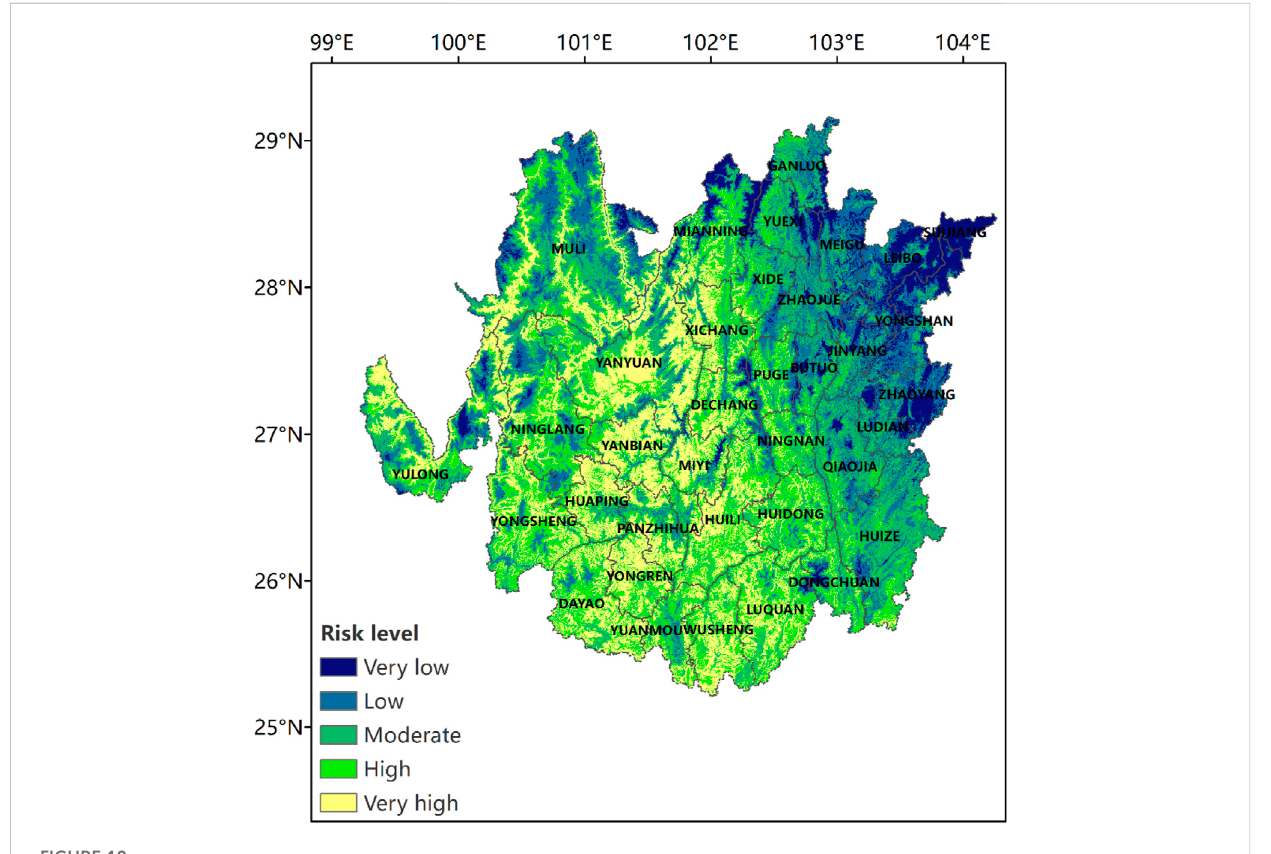
FIGURE 10 Spatial pattern of synthesized risk